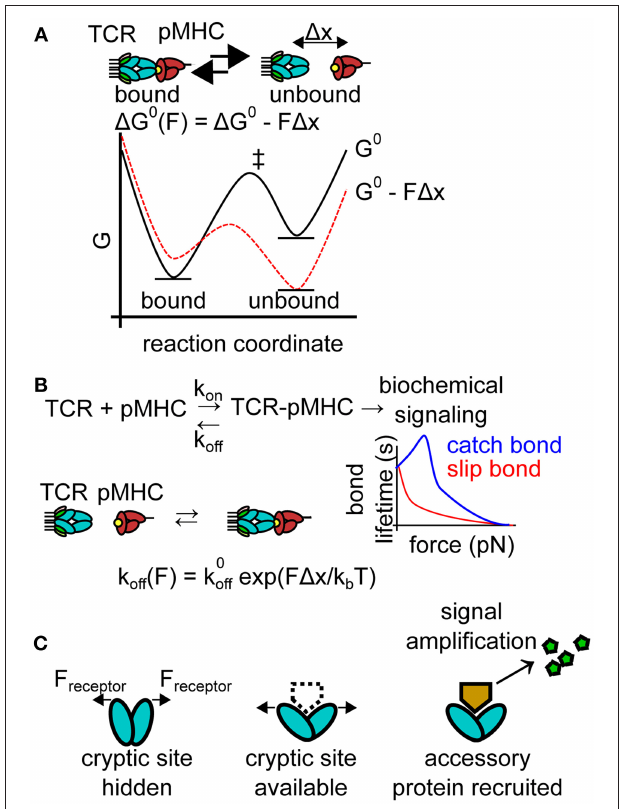
FIGURE 2 | Effects of pN forces on receptor-ligand interactions. (A) Molecular forces may skew the energy landscape of ligand binding. Under most conditions, pN molecular forces destabilize receptor-ligand complexes, shifting thermodynamic equilibrium. The plot depicts an idealized free energy diagram for a two-state receptor-ligand interaction in the presence and absence of pN force. G 0 , standard free energy of the interaction pathway in the absence of force; 1 x, distance to the transition state of receptor-ligand unbinding; and ‡ indicates the transition states on the free energy diagram. (B) Molecular forces also generally reduce bond lifetime (increasing k off under force). This force-dependent reduction in bond lifetime is known as a slip bond and is well-described mathematically by the Bell model. Select bonds exhibit increased bond lifetime under force, a phenomenon known as a catch bond. The plot depicts the force-bond lifetime relationship for idealized catch and slip bonds. k off 0 , zero-force off rate; k B , Boltzmann constant; T, temperature. (C) Molecular forces may also alter the energy landscape of a protein, facilitating conformational shifts, exposing cryptic binding sites for accessory proteins (dotted line). Accessory proteins may produce secondary messengers, amplifying the signal produced by force-induced conformational